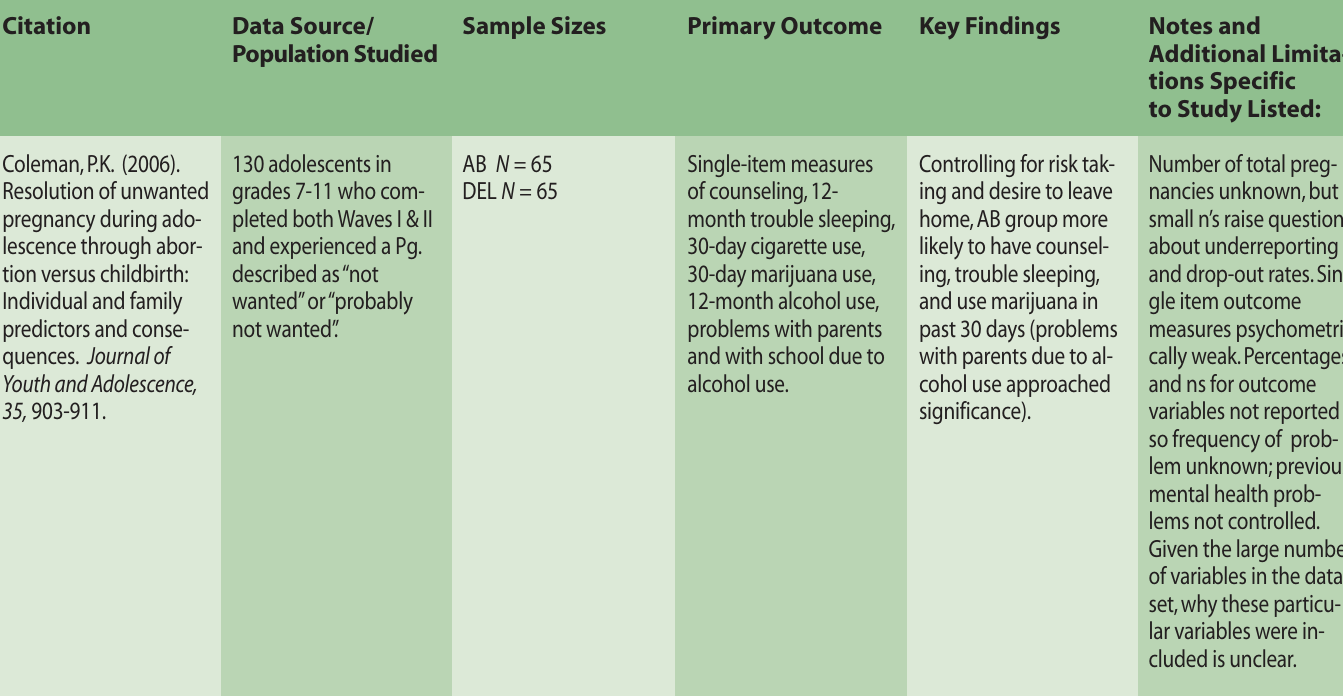
Table 1B: Secondary Analyses of Survey Data–Abortion vs.Comparison Groups U.S.STUDIES